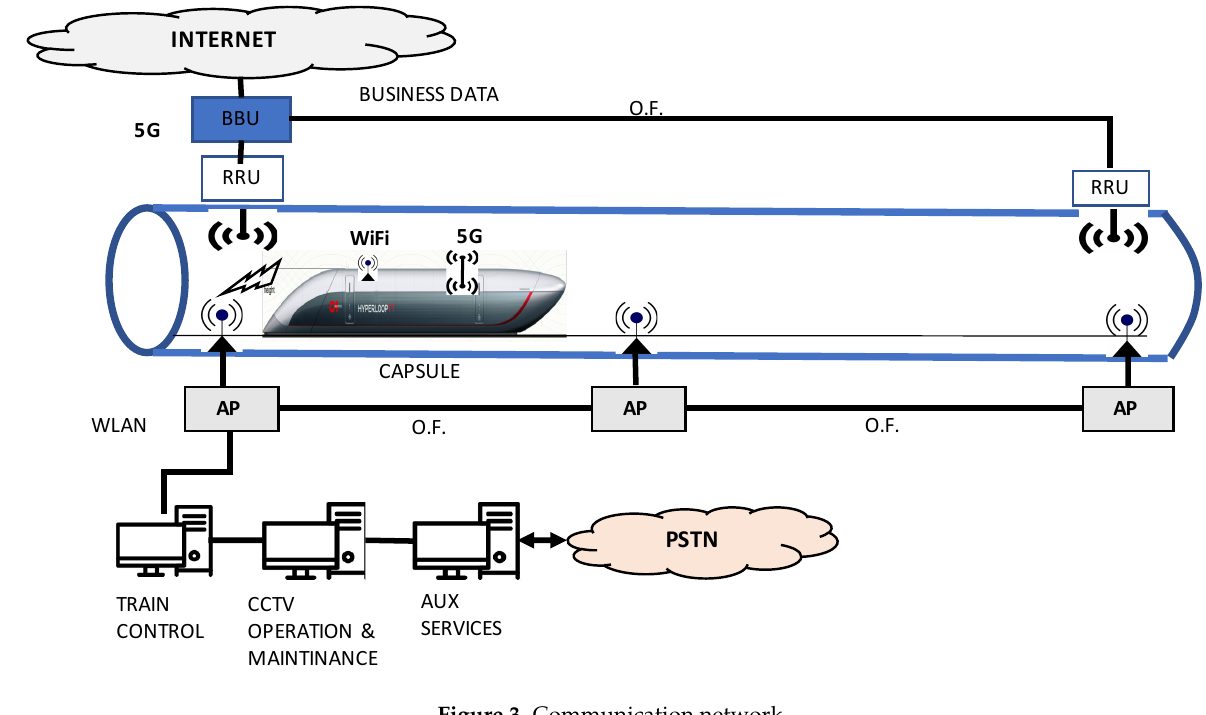
Figure 3. Communication